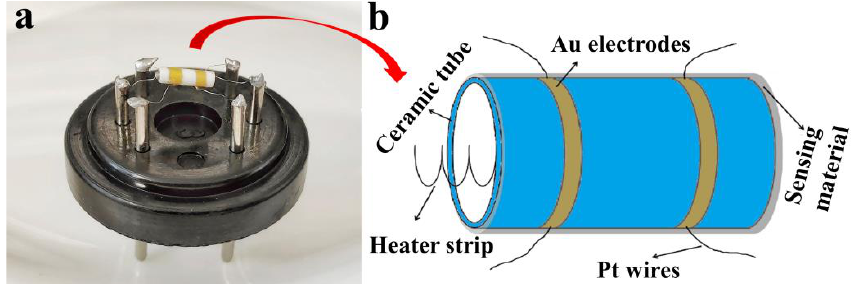
Figure 1. ( a ) Actual image of a hexapod ceramic tube gas sensor; ( b ) Illustration of ceramic tube Au